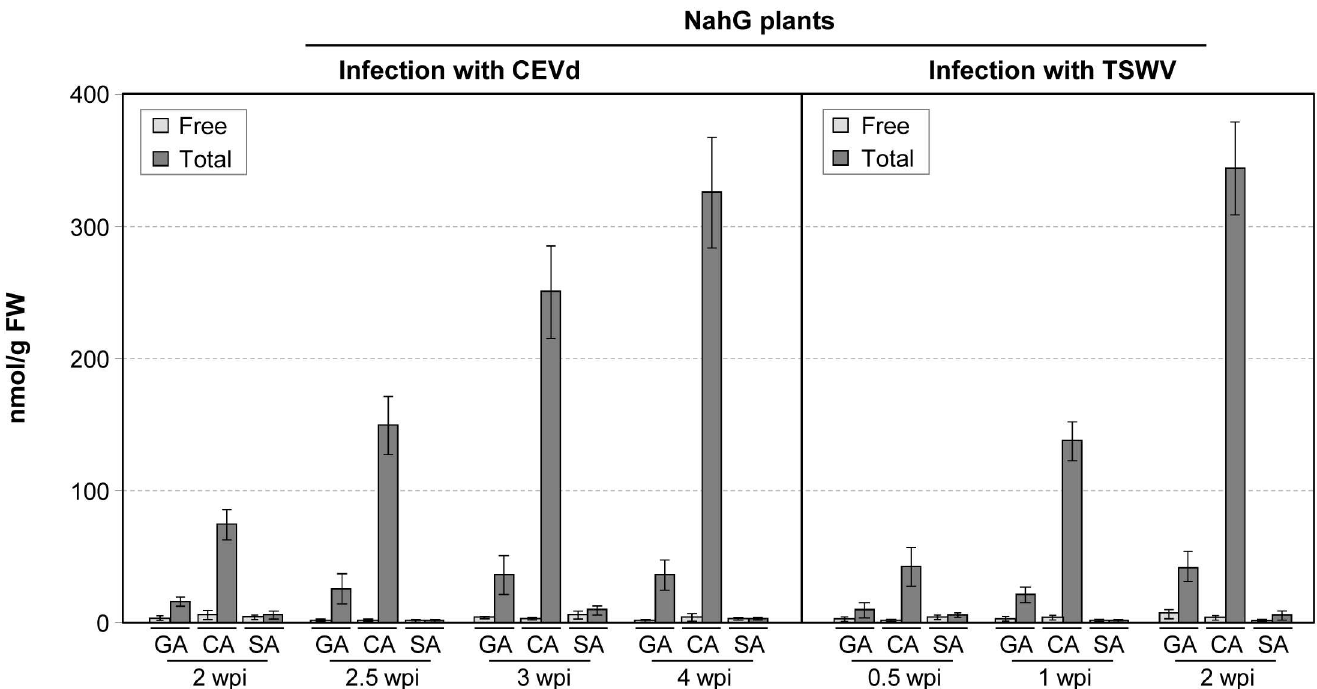
Fig 2. Accumulation of phenolic compounds in NahG plants infected with citrus exocortis viroid (CEVd) or tomato spotted wilt virus (TSWV). Levels of free and total gentisic acid (GA), salicylic acid (SA) and catechol(CA) in infected NahG tomato leaves. Plants were inoculatedwith either CEVd or TSWV and samples were collectedat the indicatedtimes (weeks post-inoculation, wpi), and then analyzedby HPLC-fluorescence detection. Total phenolicsare the sum of free and glycosylatedforms. Data correspond to the mean ± SD of three biologicalreplicatesof one representative experiment. The experiments were repeatedat least 3